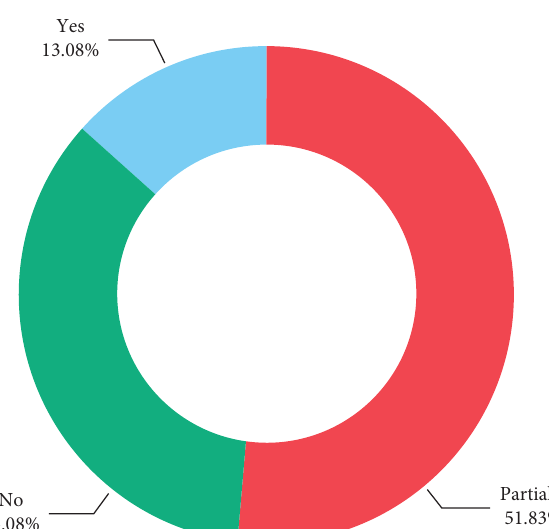
Figure 7: Use of materials produced by professors. Figure 8: Satisfaction with the supporting materials produced by the